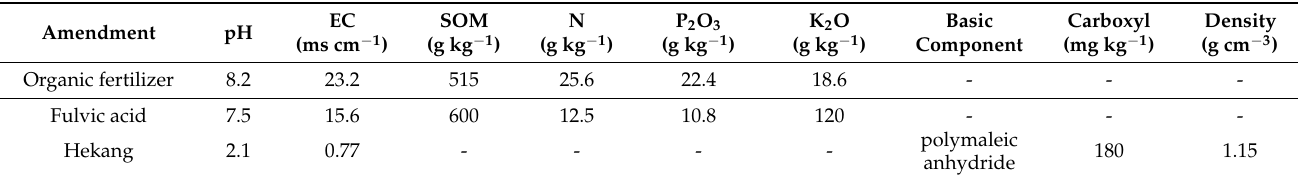
Table 2. Basic composition and content of amendment